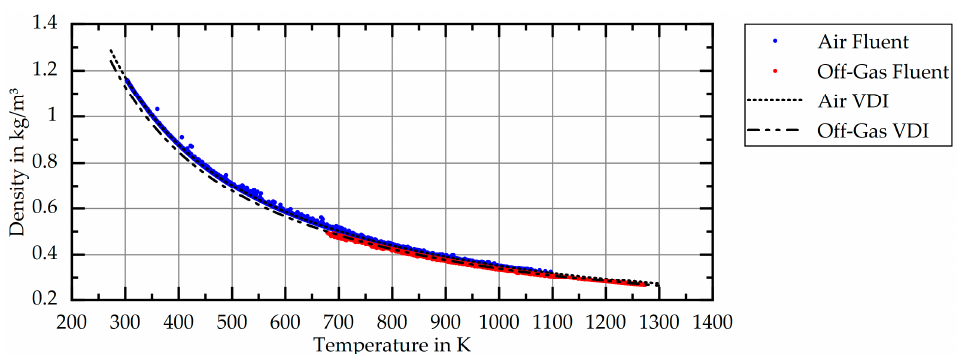
Figure A1. Sampled data points of the fluid density of air and off-gas at λ = 1.15 calculated in ANSYS ® Fluent in comparison with values calculated with methods described in [20].